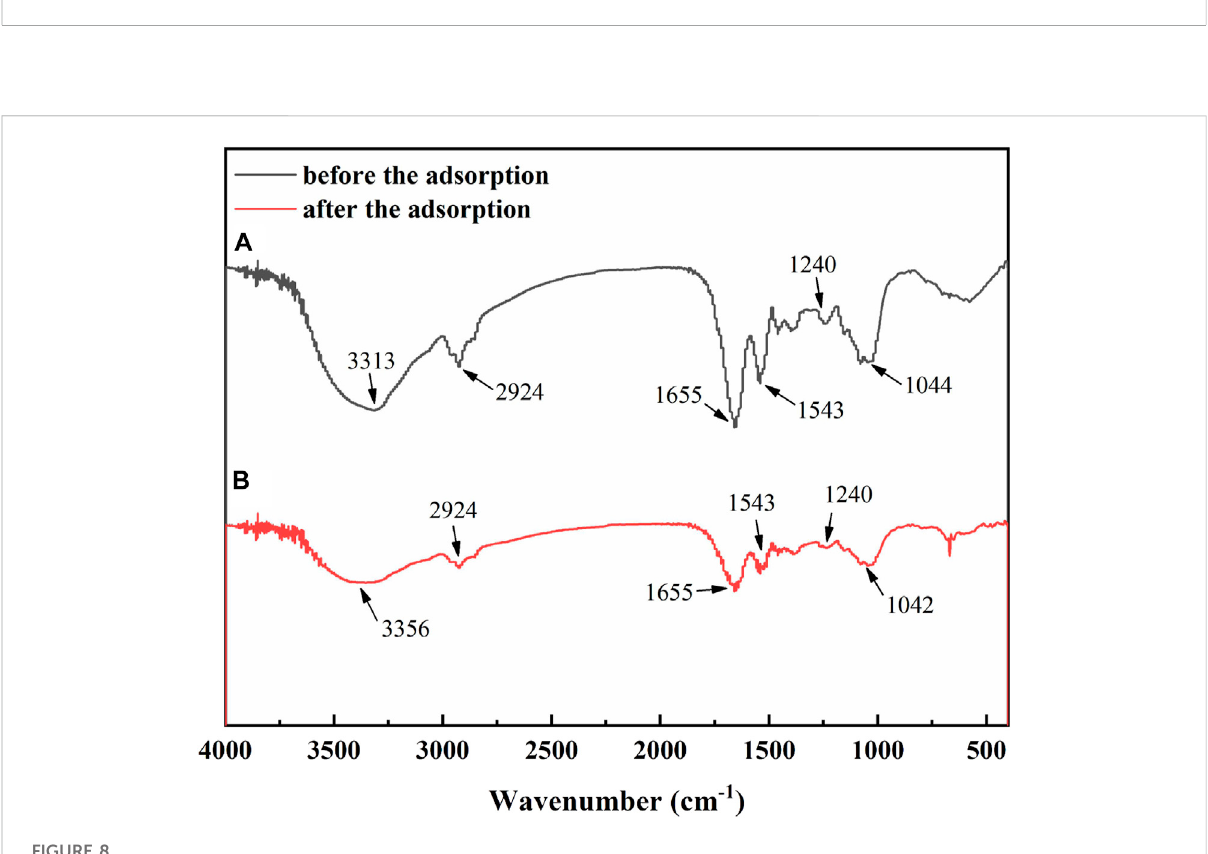
FIGURE 8 FTIR spectra of CP powder before and after